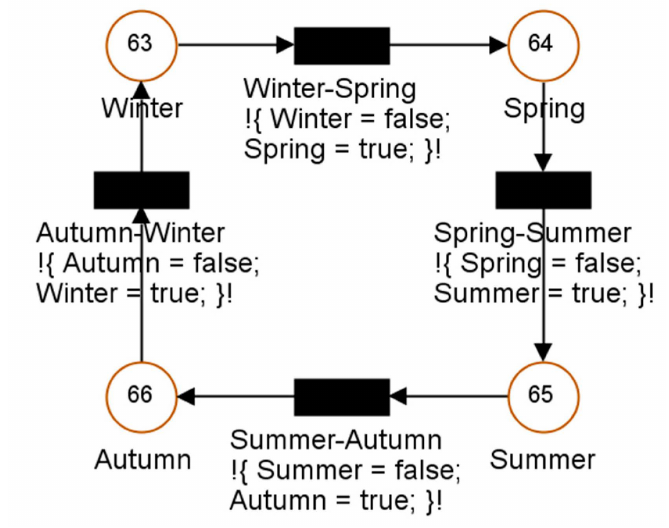
Figure 5. PN model for